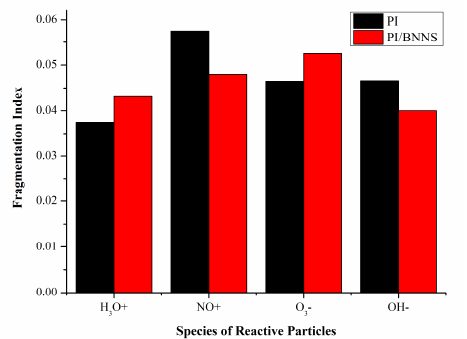
Figure 14. Fragmentation index of the different systems at 100 ps.